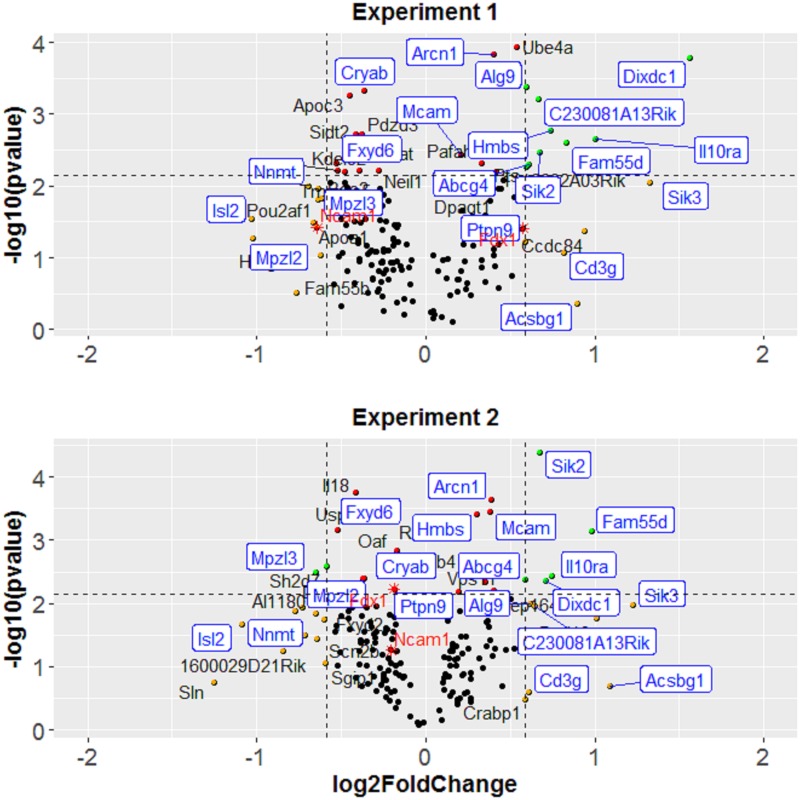
Extraction of differentially expressed genes.Filtering on a volcano plot of the microarray data analysis of the Experiment 1 (top) and Experiment 2 (bottom). In Experiment 1, we selected the gonadal adipose tissue from male mice from congenic strain 4 with the donor region captured QTL1, QTL2, and QTL3 (42.6 to 58.3 Mb). Half of the mice were heterozygous for the donor region (129/B6; N = 7), and half were littermates homozygous for the donor region (B6/B6; N = 7). Experiment 2 replicated Experiment 1 except with N = 6 mice in each genotype group, for a total of 12 mice. The customized volcano plots depict the estimated log2-fold change (x-axis) and statistical significance (−log10 p-value; y-axis). Each dot represents one gene. The green dots show genes with absolute log2-fold change > 0.58 (i.e., 1.5-fold change) and false discovery rate < 0.05; the red dots show genes with false discovery rate < 0.05; the yellow dots show genes with absolute log2-fold change > 0.58; the black dots show genes that did not reach these statistical thresholds. We label genes that passed any filters by name. Twenty differentially expressed genes are reproducible between Experiment 1 and 2, labeled with blue text and square boxes. Red stars show two genes that passed the filters in one but not both experiments yet are noteworthy because their human orthologues are associated with adiposity or body mass index in genome-wide association studies (Table 2). We summarize the additional experimental details in S12 Table.